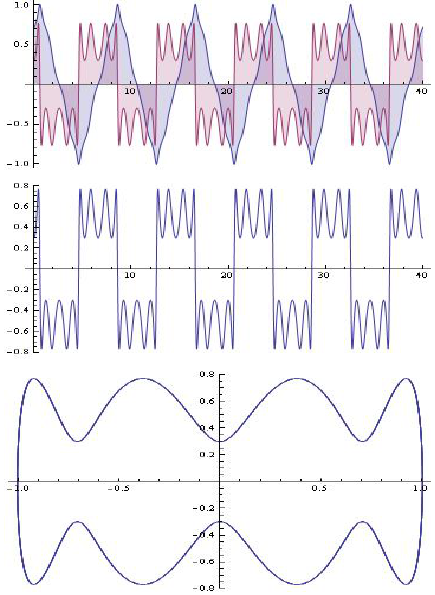
Figure 12. The solutions of the system (12) (Example 1).